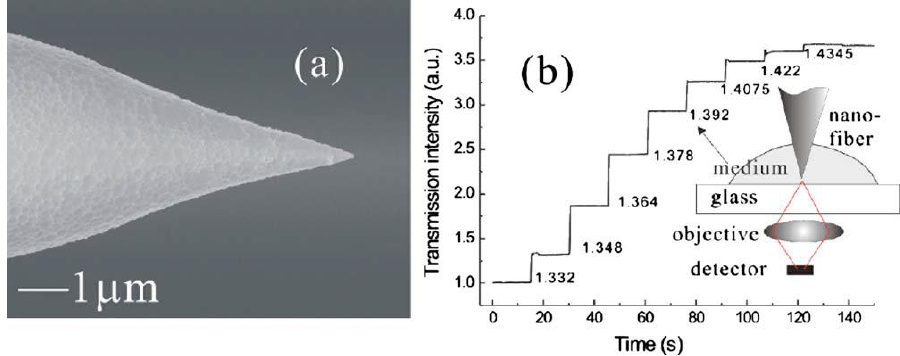
Figure 12. ( a ) SEM image of the fiber tip modified by the etching method; ( b ) measured intensities in different RI media [197].